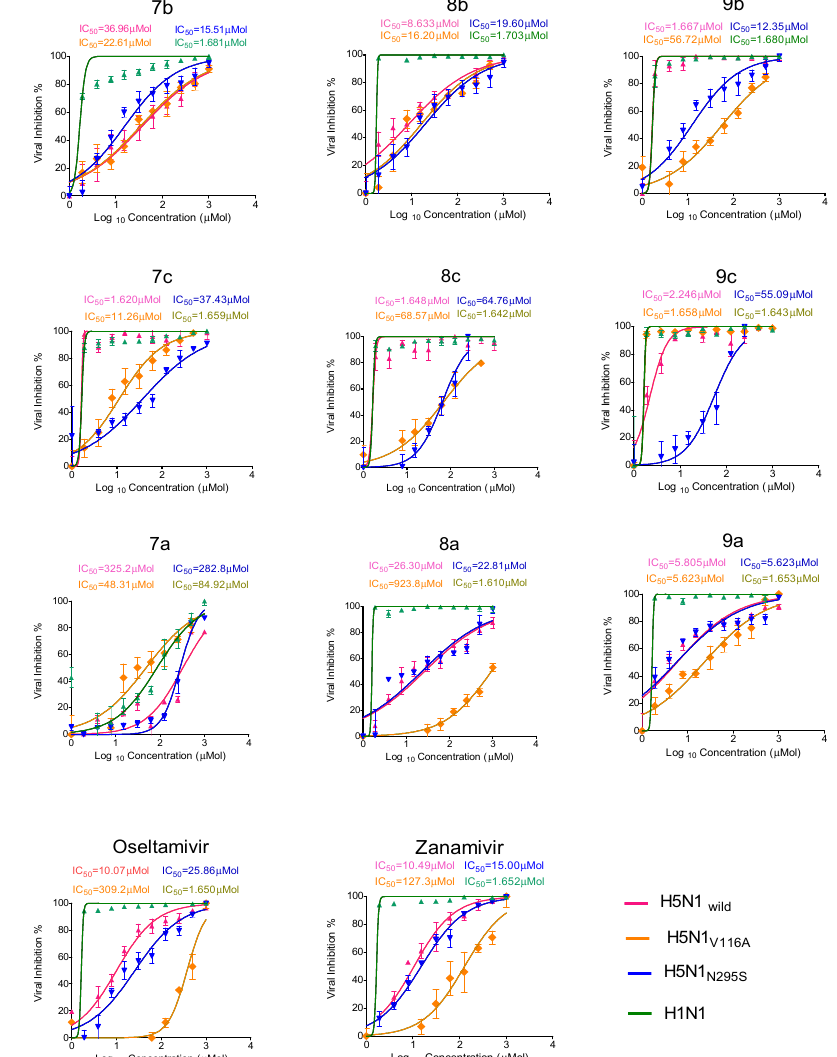
Figure 5. The 50% Inhibitory concentration (IC 50 ) of new synthetic compounds, oseltamivir, and zanamivir against H5N1 wild , H5N1 V116A , H5N1 N295S , and H1N1 viruses.